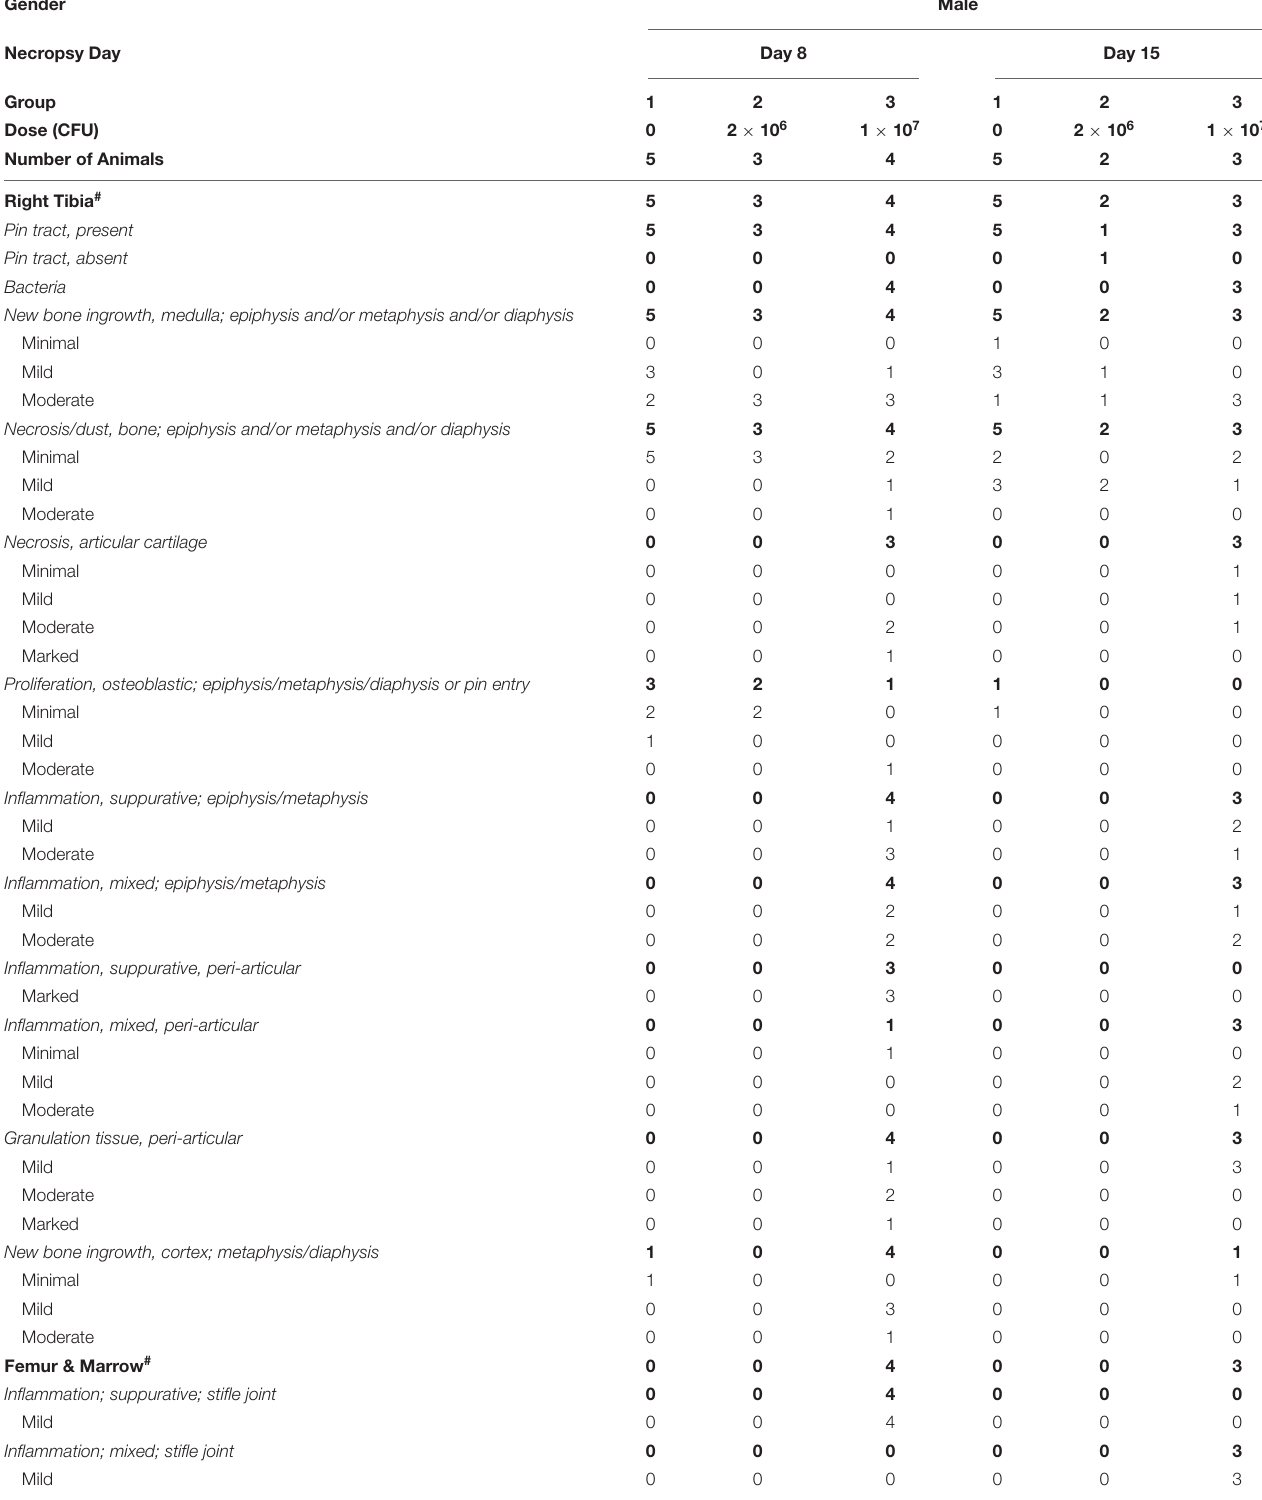
TABLE 3 | Group incidence and severity of S. aureus intramedullary implant-related microscopic changes. Gender